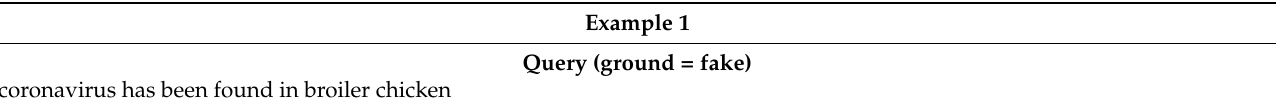
Table 3. Examples of answers provided by the system for different input queries (case study n. 1).